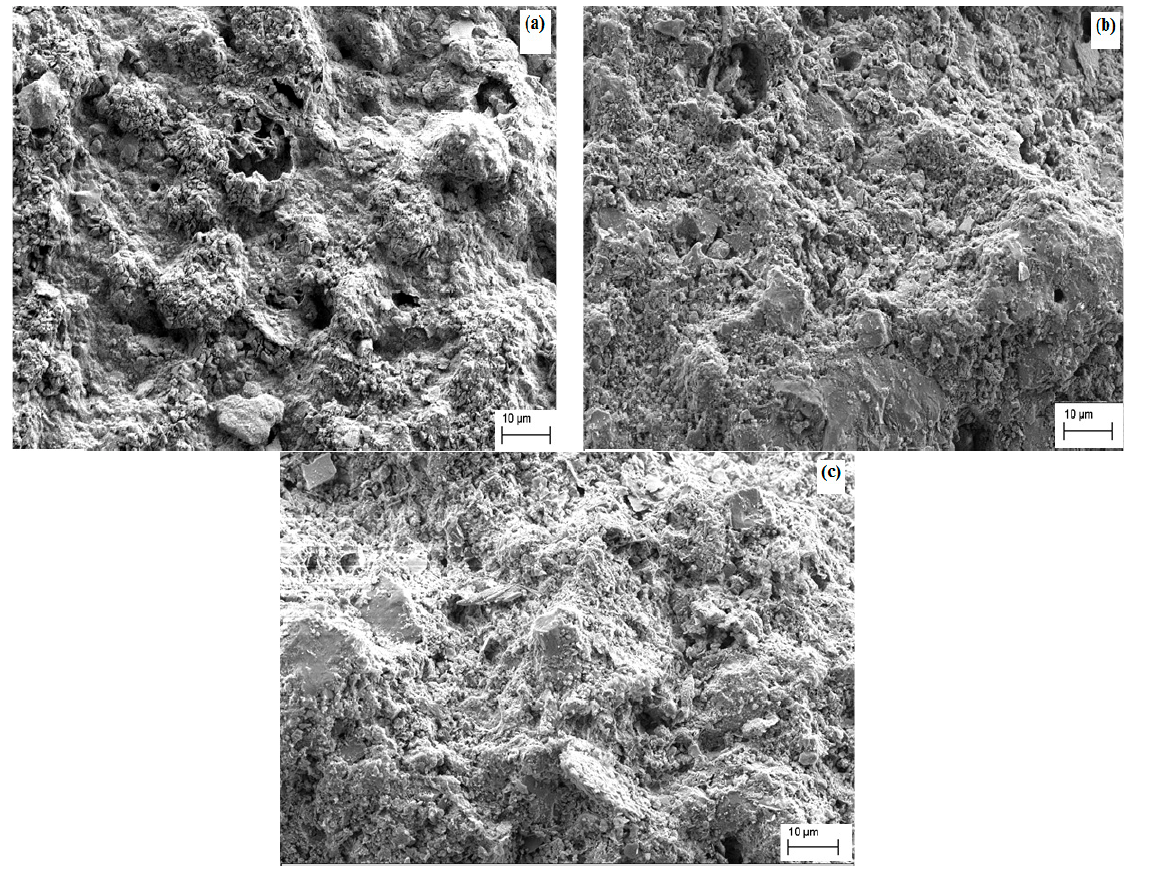
Figure 2. SEM micrographs of composite kaolin/zeolite membrane surface: sintered at 820 °C ( a ) 850 °C ( b ) and sintered at 880 °C ( c ).